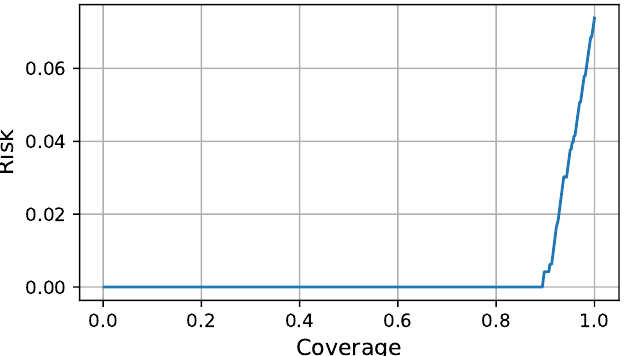
Figure 4. Optimal Risk-Coverage